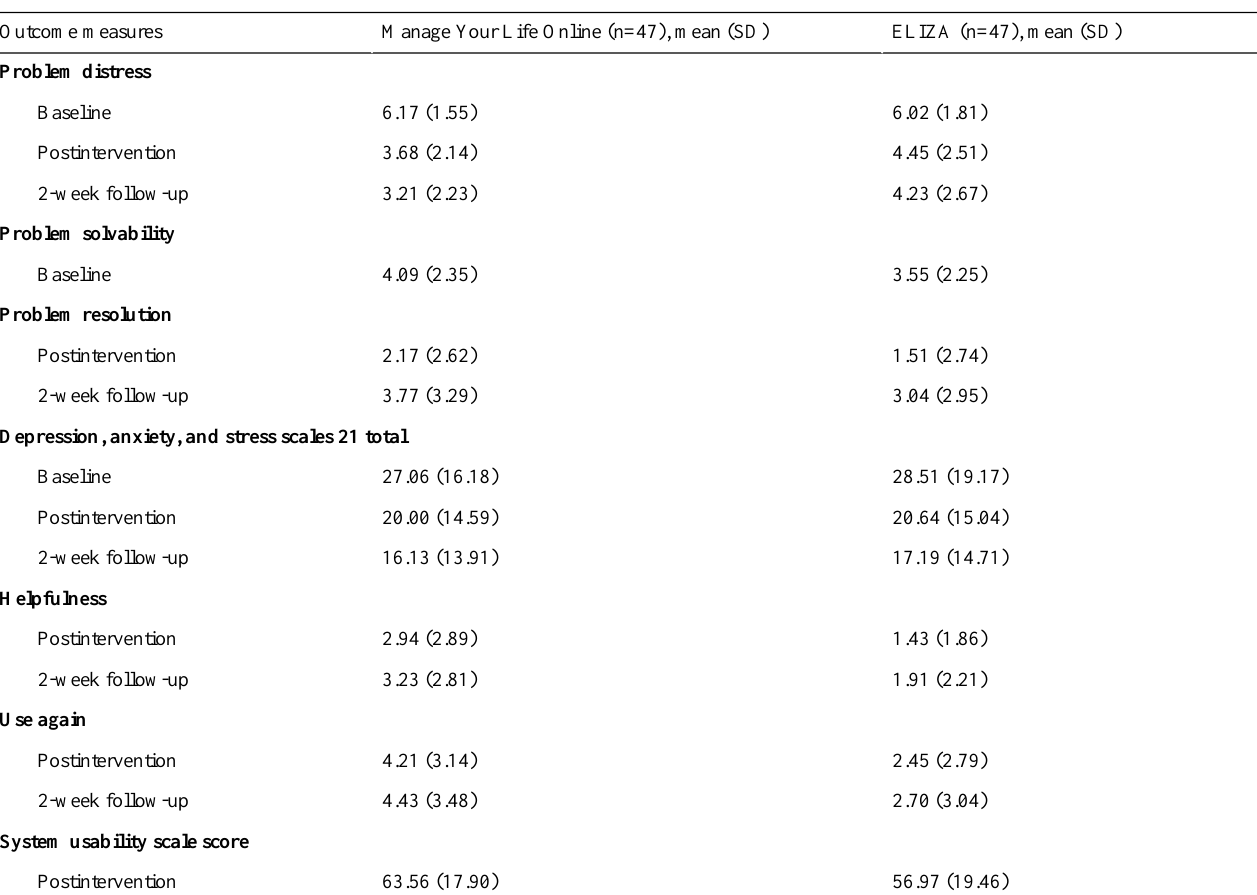
Table 2. Mean (SD) for measures at baseline, postintervention, and 2-week